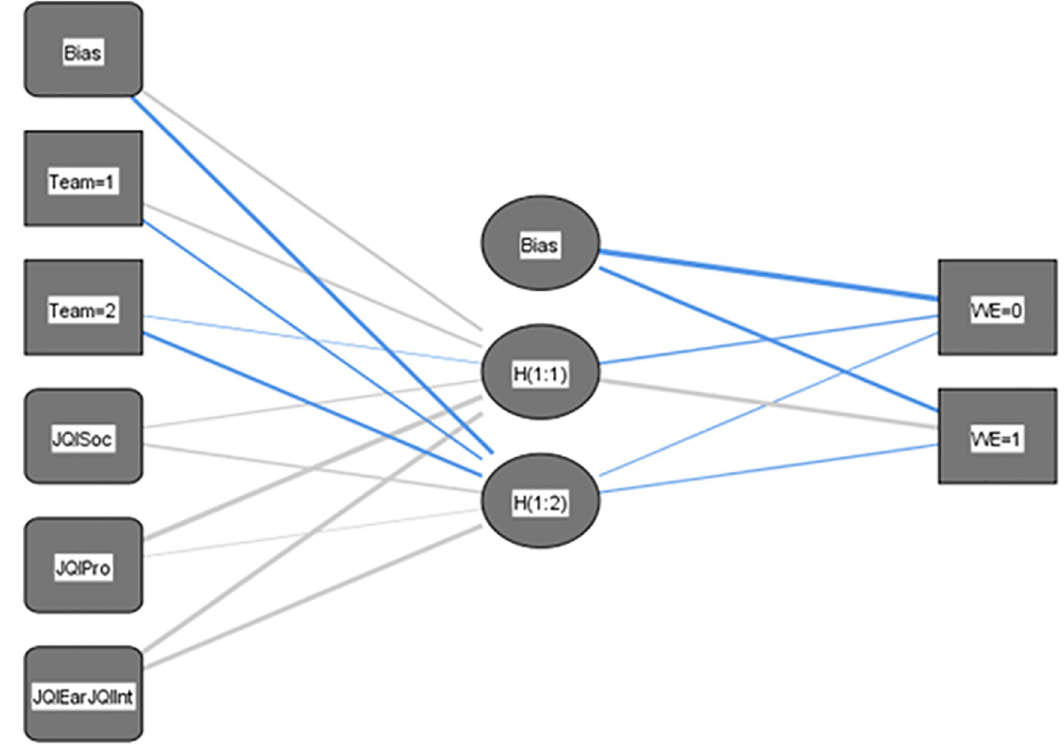
Fig 4. Artificial neural network MLP (5+1; 2;